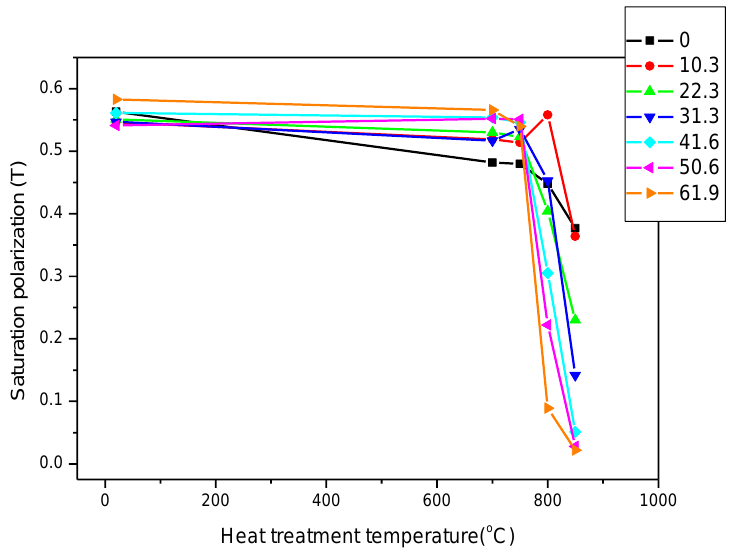
Figure 7. Saturation polarizations of all samples as a function of the temperature of the heat treatment. The parameter is the rolling reduction.